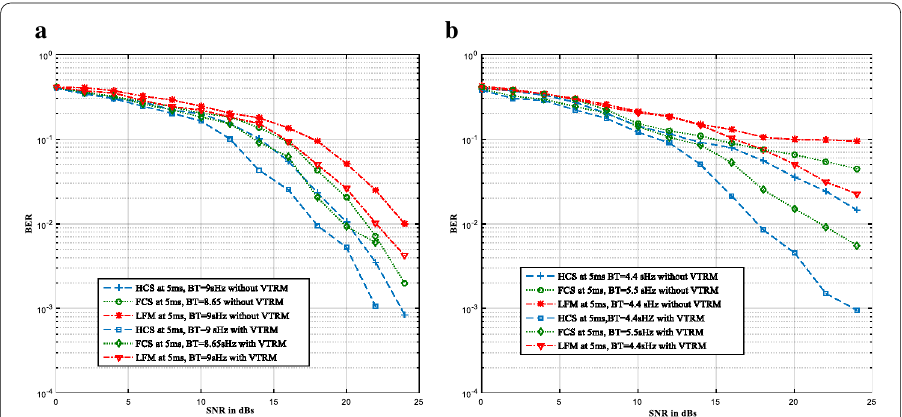
Fig. 17 BER versus SNR graph proposed system in watermark channel a BER versus SNR graph of HCS Chirp, FCS Chirp and LFM with SF 9sHz and 8.65, respectively, and Chirp Period 5 ms, b BER versus SNR graph of HCS Chirp, FCS chirp and LFM with SF 4.4sHz and 5.5, respectively, and Chirp Period 5